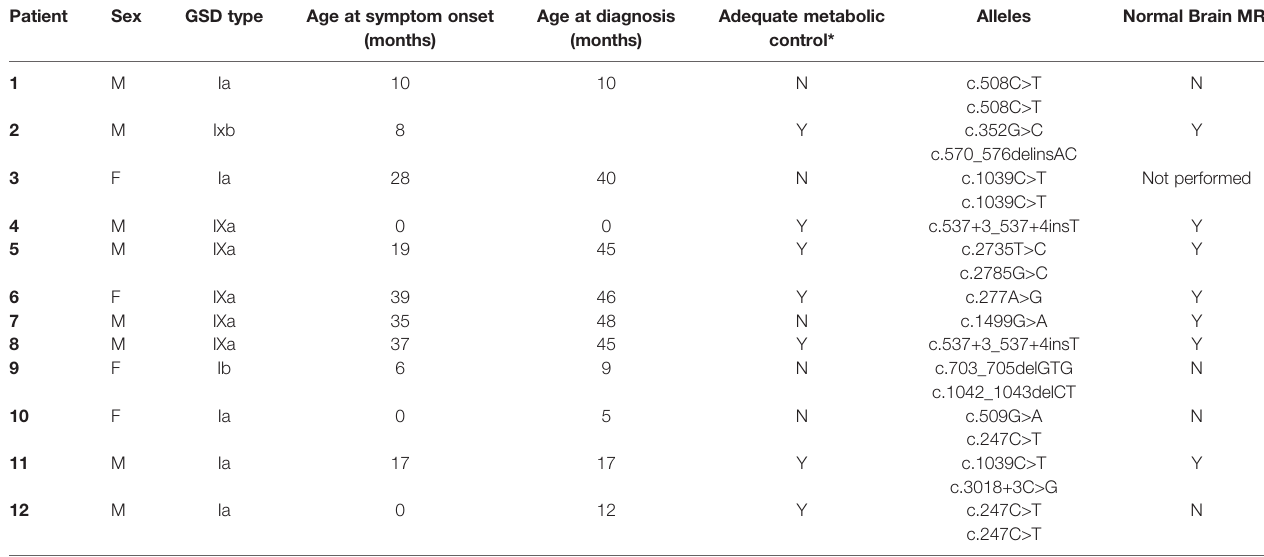
TABLE 1 | Characteristics of glycogen storage disease (GSD) patients analyzed in this study.